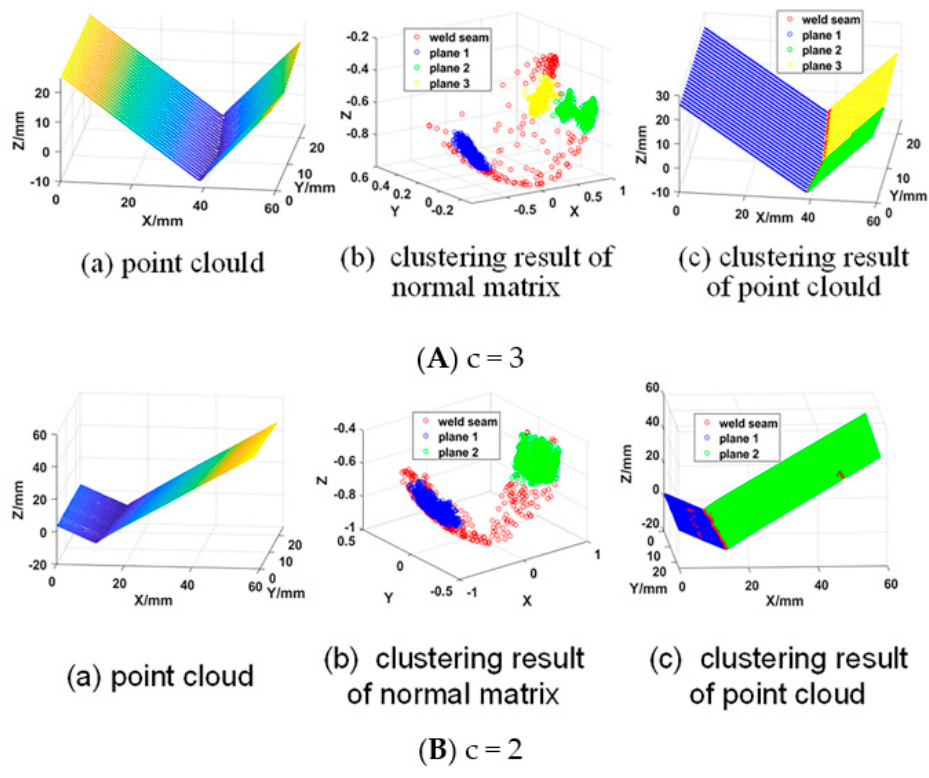
Figure 5. Point cloud segmentation results; ( a ) Point cloud; ( b ) Clustering result of normal matrix; ( c ) Clustering result of point clould.